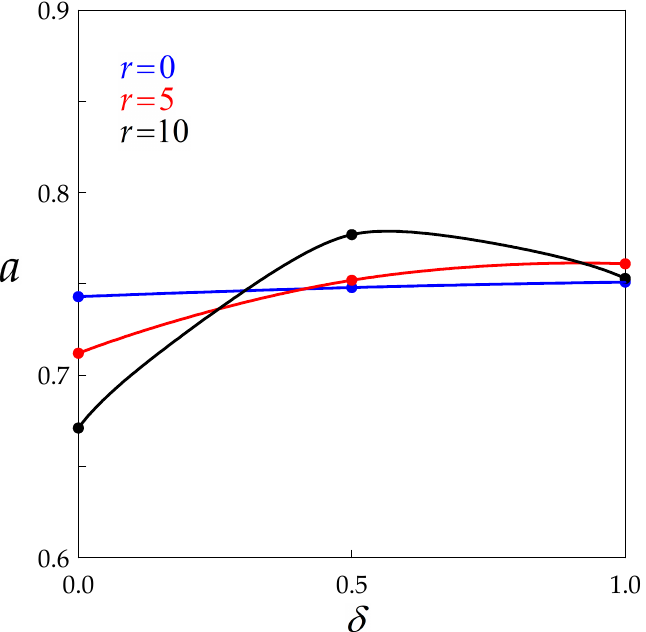
Figure 9. Dependence of the Derby exponent on BMIS for three values of the recovery parameter. Data points are connected by spline curves.